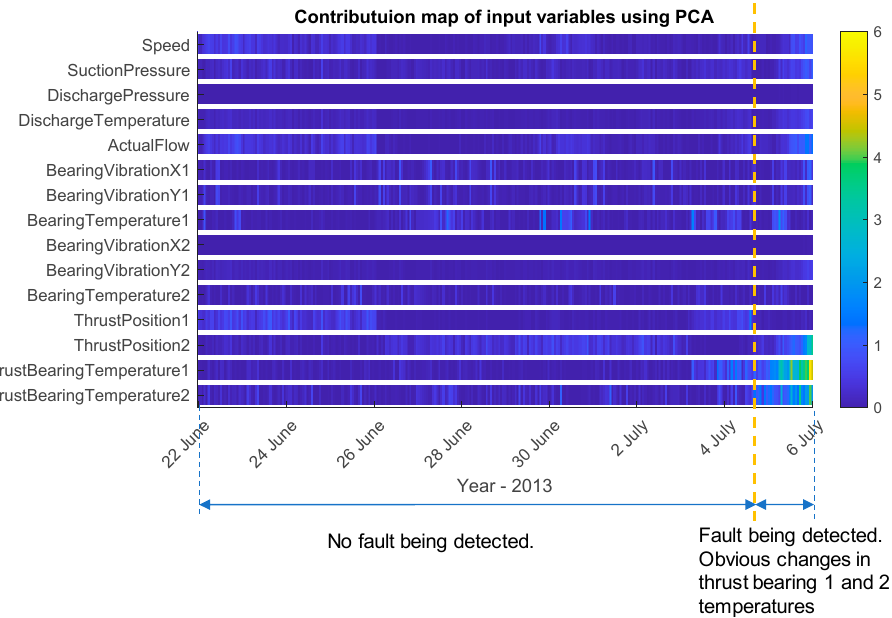
Figure 7. Contribution map by PCA model from 22 June 2013 to 6 July 2013.